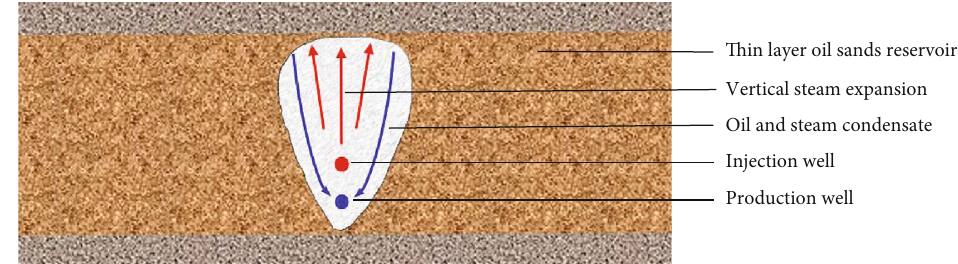
Figure 1: The SAGD concept of traditional well placement.